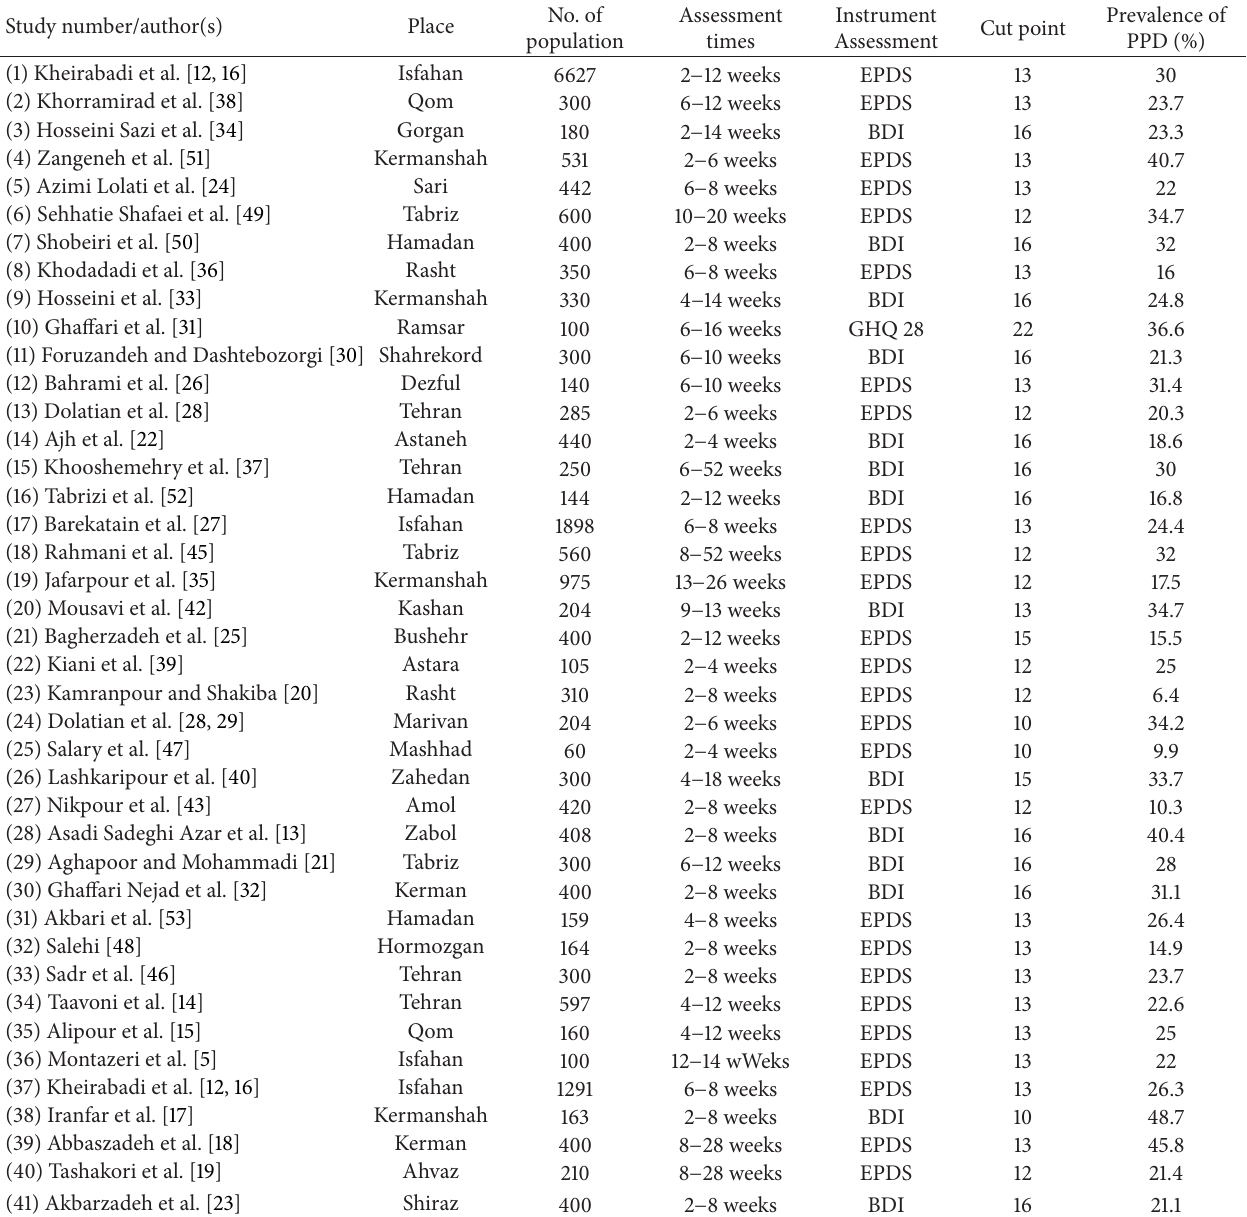
Table 1: Feature of studies among women with postpartum depression at different